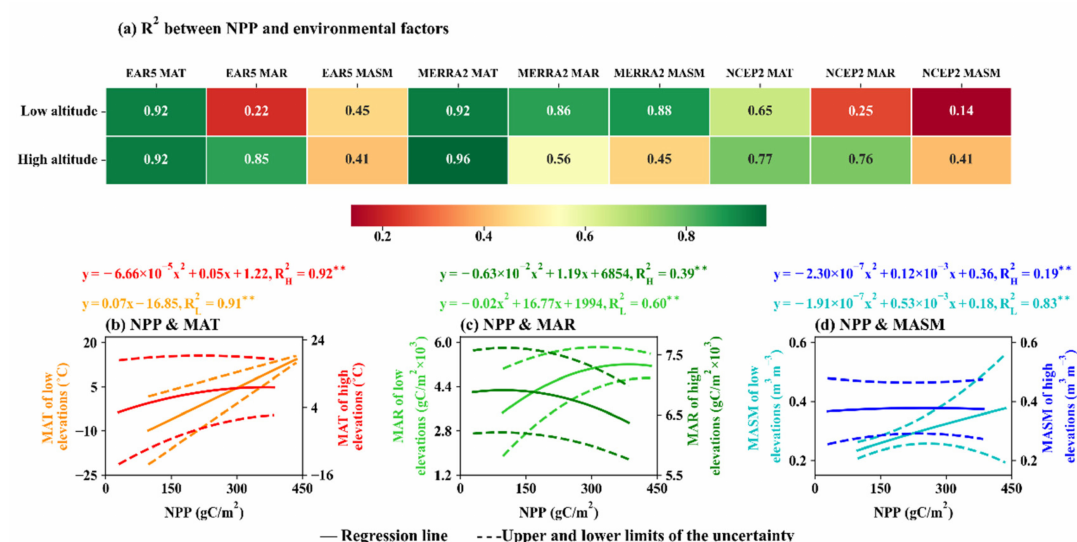
Figure 10. Regression curves, functions, and their R 2 between NPP and environmental factors. ( a ) represent R 2 between NPP and environmental factors. The regression curves and functions can be found in ( b – d ). Subscript L of R 2 means low elevations, and H means high elevations, and ** denotes the R 2 is significant at the 0.01